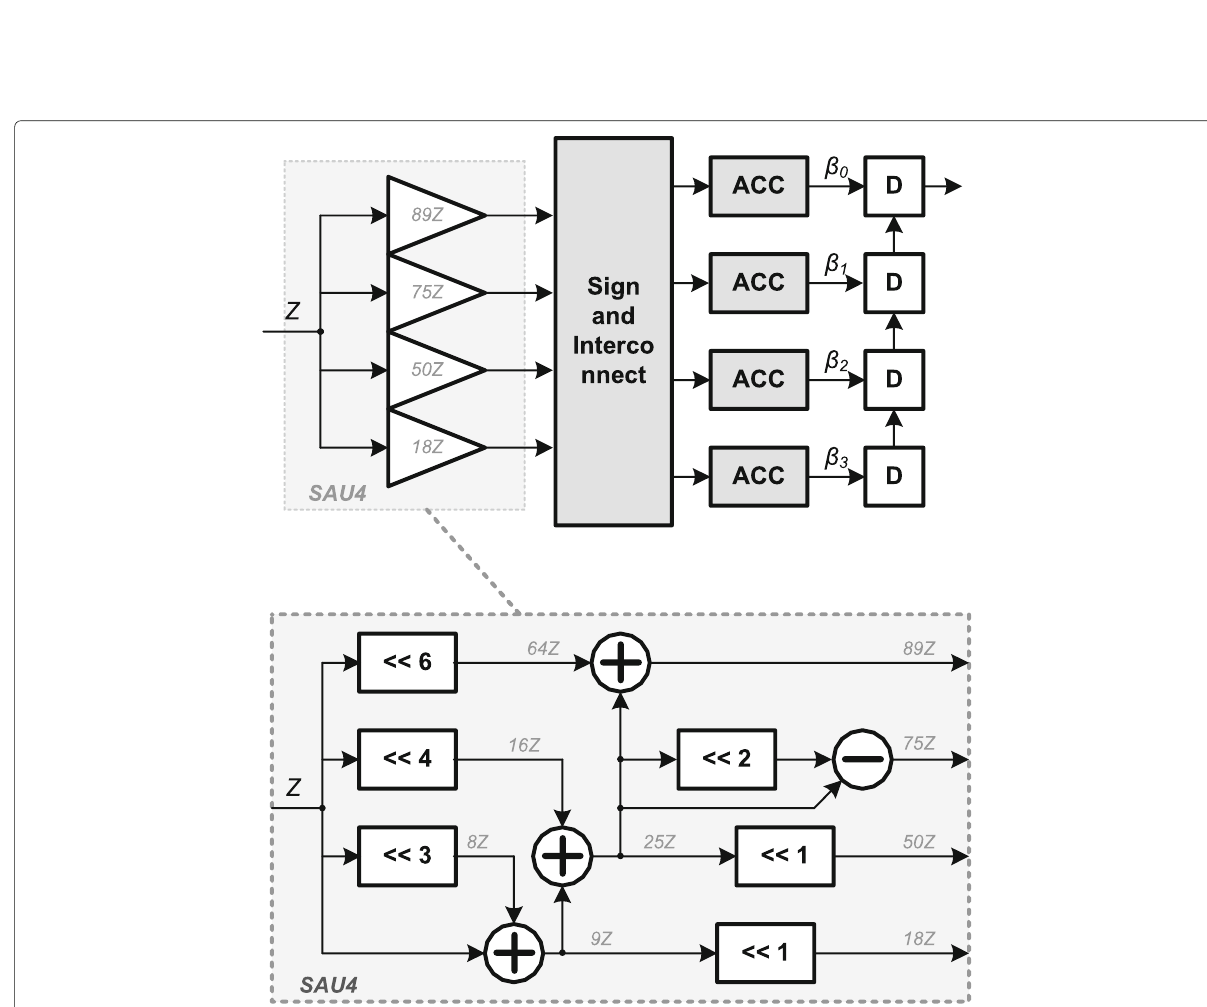
Fig. 3 Architecture of the PEO4